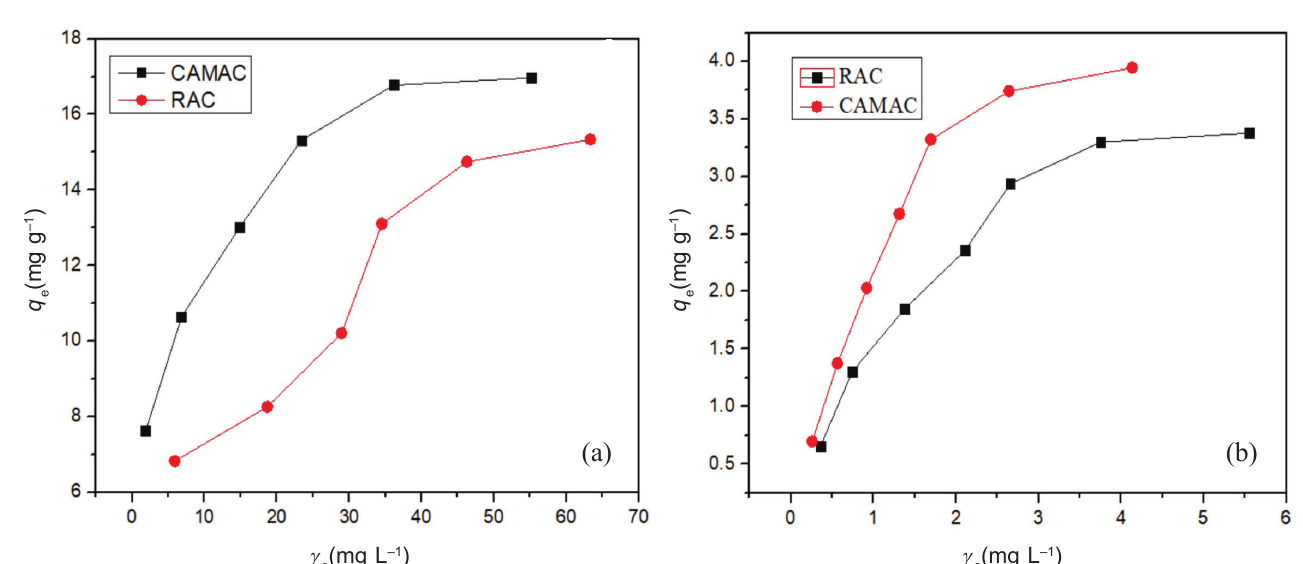
Fig. 9 – Effect of initial concentration on adsorption of Cu(II) ions (a) and for As(III) ions (b) onto RAC and